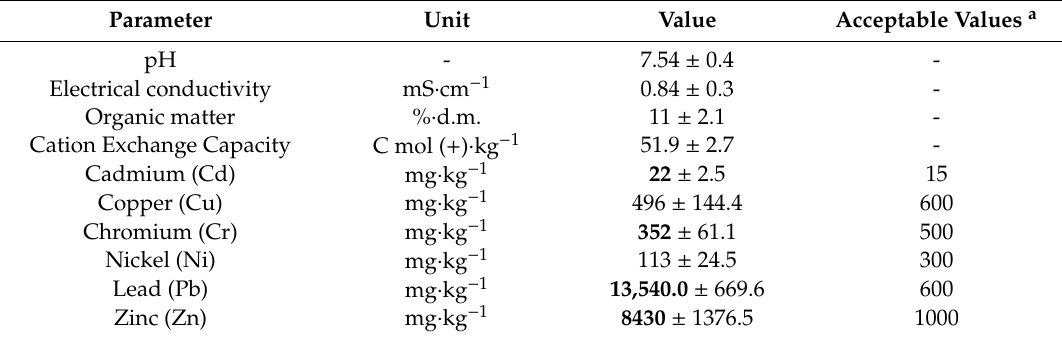
Table 2. Selected properties of the analyzed